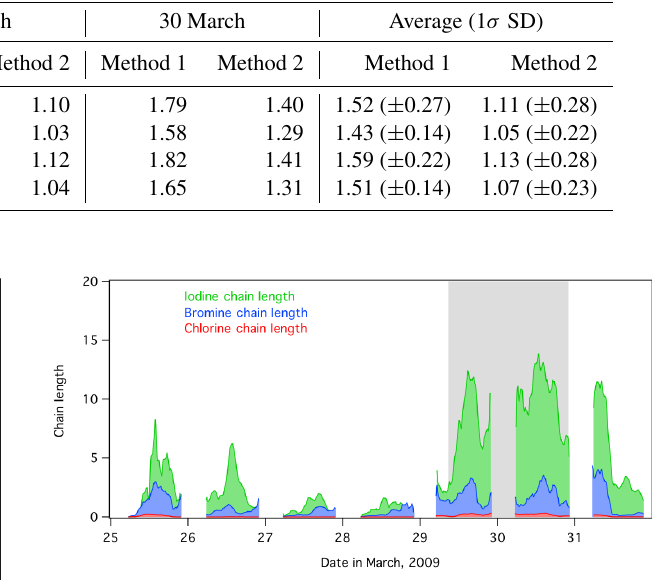
Figure 5. Calculated chain lengths for iodine (green), bromine (blue), and chlorine (red) across the 7 days of the simulated pe- riod modeled using the base + iodine scenario. Model output is smoothed by hourly averaging. The grey-shaded box represents a period of missing Br 2 observations. Time is expressed in Alaska standard